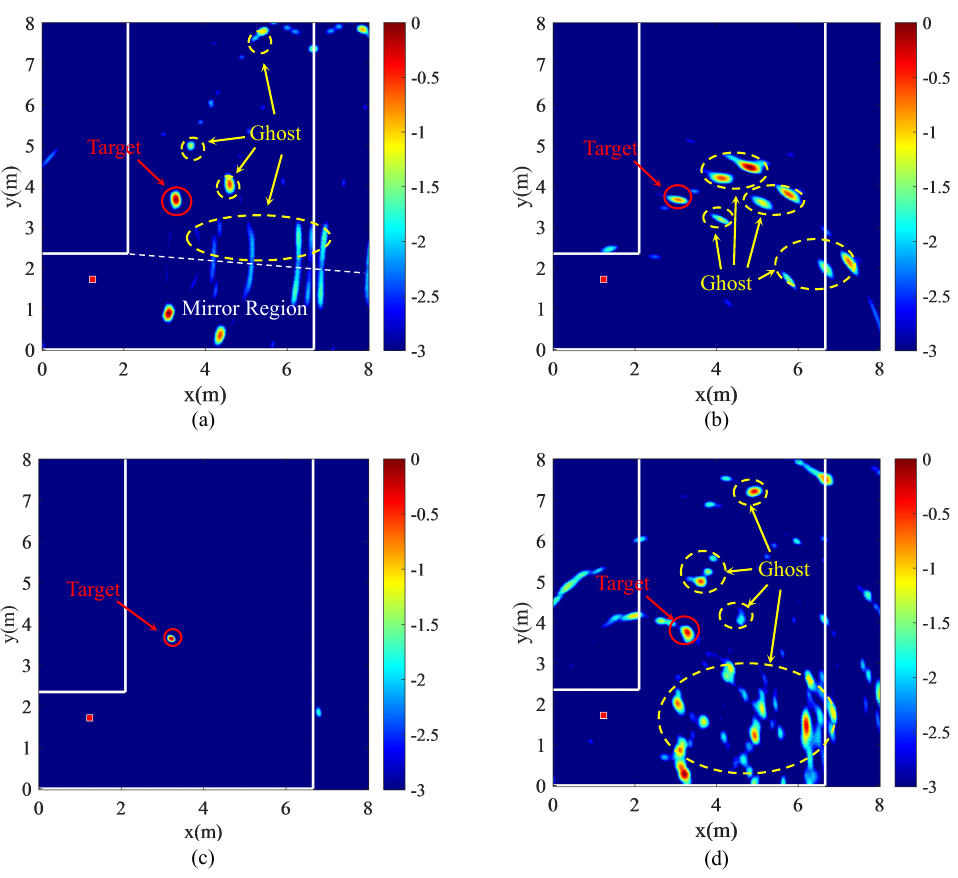
Figure 11. Multipath imaging results via dual-view in single target scenario. ( a ) Imaging result of Path -1, Path -3 and Path -5 through range profiles of View 1. ( b ) Imaging result of Path -2 and Path -6 through range profiles of View 2. ( c ) Fusion of ( a , b ). ( d ) Imaging result of previous